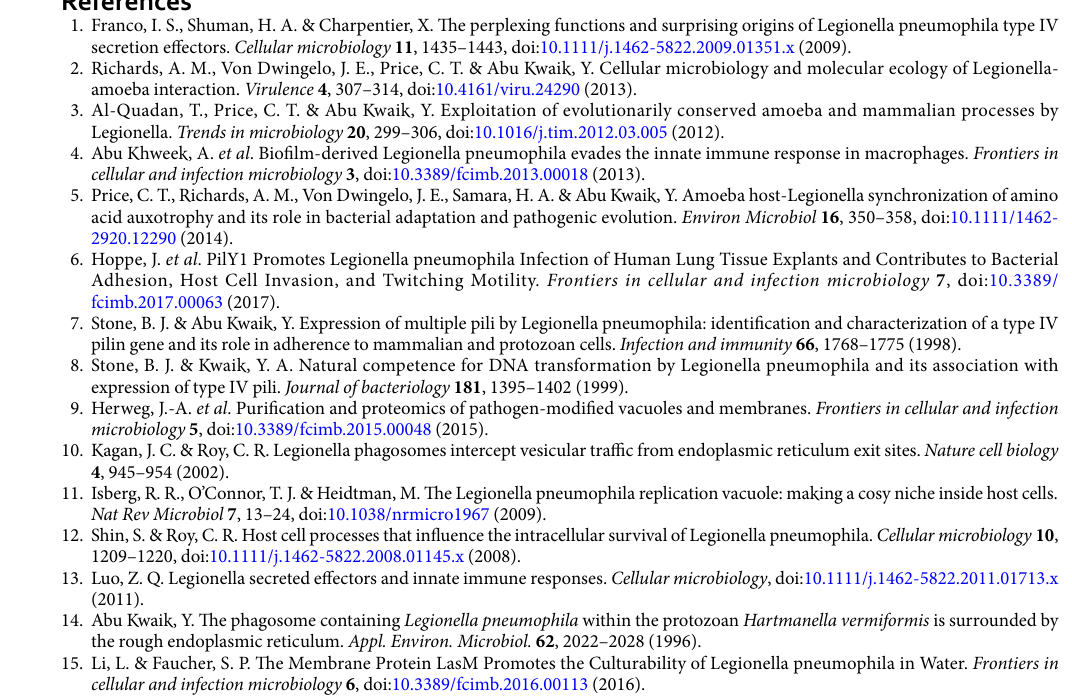
(Table S1): (1) M2N2A1, which specifically tested for evidence of positive selection in the clade leading up to ankB1 and ankB8; and (2) M2N2A2, which specifically sought evidence for positive selection in the ankB1 branch itself. The fit of each model to the data was tested via LRTs with 1 degree of freedom and that measured the difference in the likelihood score of each model (e.g., M2N2A1) with a constrained version whereby ω for the branch suspected to be under positive selection was fixed at 1 (e.g. M2N2A1 ω f). It has been suggested that selection of branches of interest to test for selection, or testing one branch at a time can sometimes lead to statistical instability or acceptance of poorly supported models 67 . Thus to confirm the outcomes of our CODEML branch site results, we performed supplemental analysis for detecting all branches that may have significantly experienced positive selection in their evolutionary history with the GA (genetic algorithm) branch method implemented at